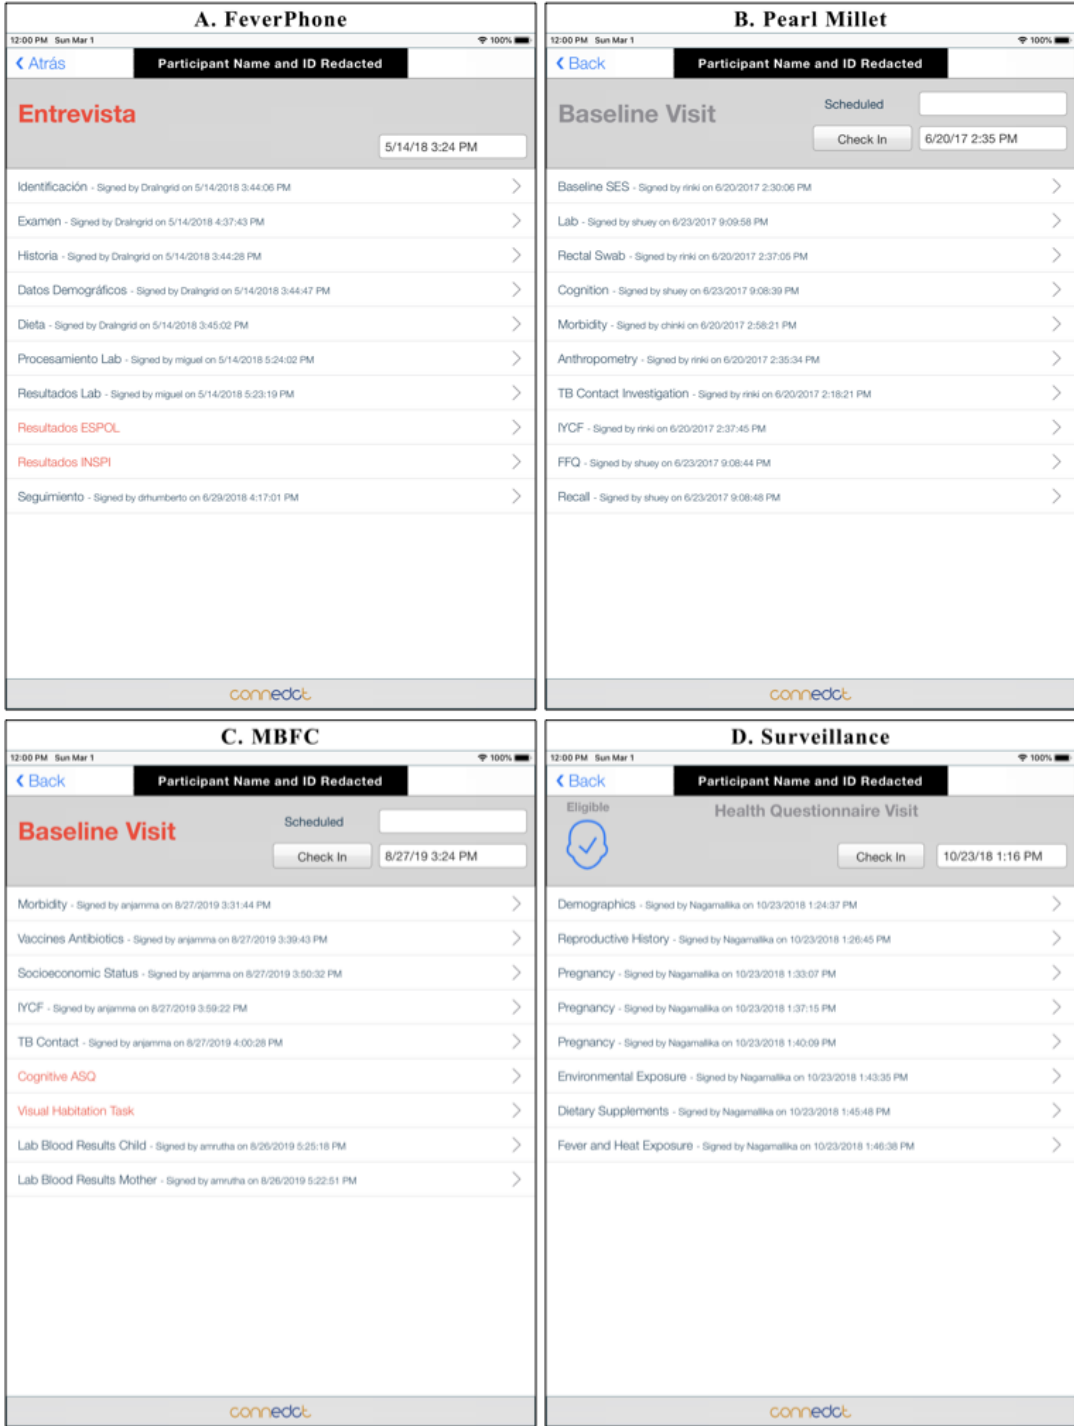
Figure 3. Schedule of visits for (A) clinical setting: FeverPhone, Ecuador; (B) RCT, Mumbai; (C) RCT, South India; (D) surveillance study, South India. RCT: randomized controlled